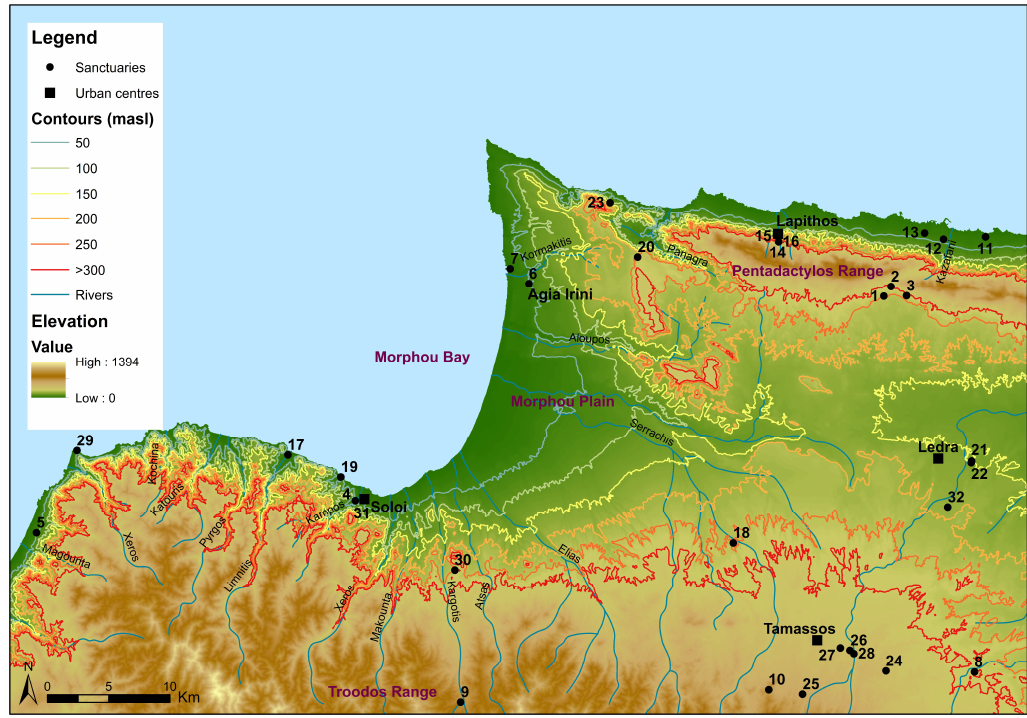
Figure 7. Environmental map; Digital data courtesy of the Geological Survey Department, Cyprus (by Charalambos